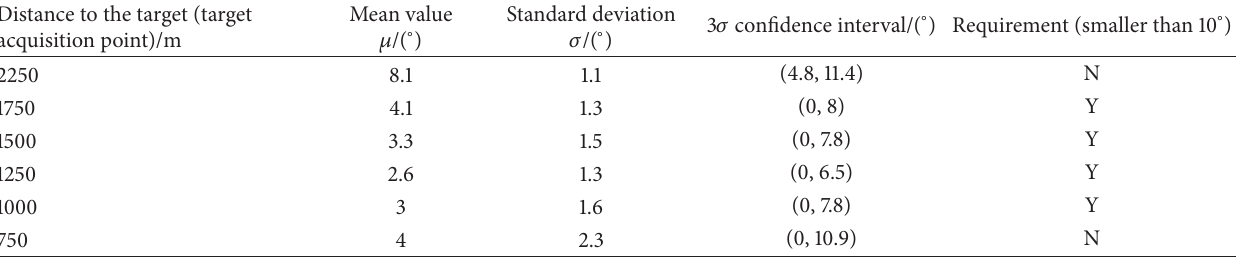
Table 2: View angle distribution results (fixed target).